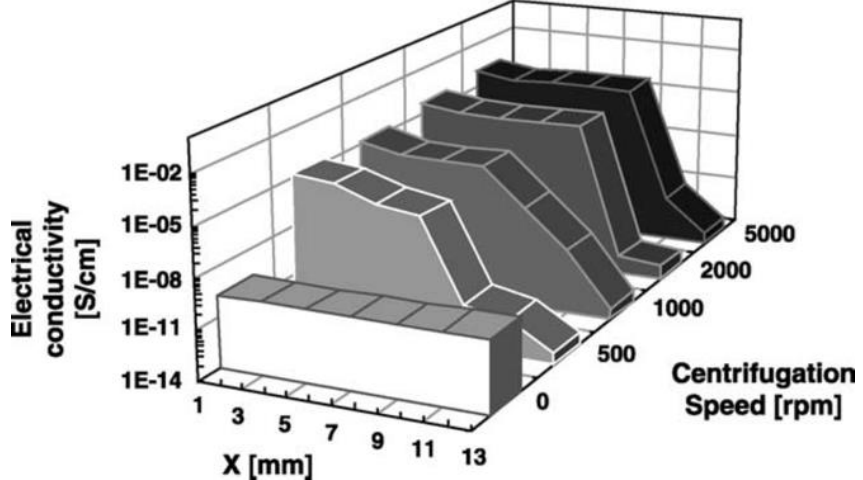
Figure 49. Distribution of electrical conductivity in carbon fibers/epoxy resin composites for different centrifugation speeds. Reprinted from [124], Copyright 2003, with permission from Elsevier.